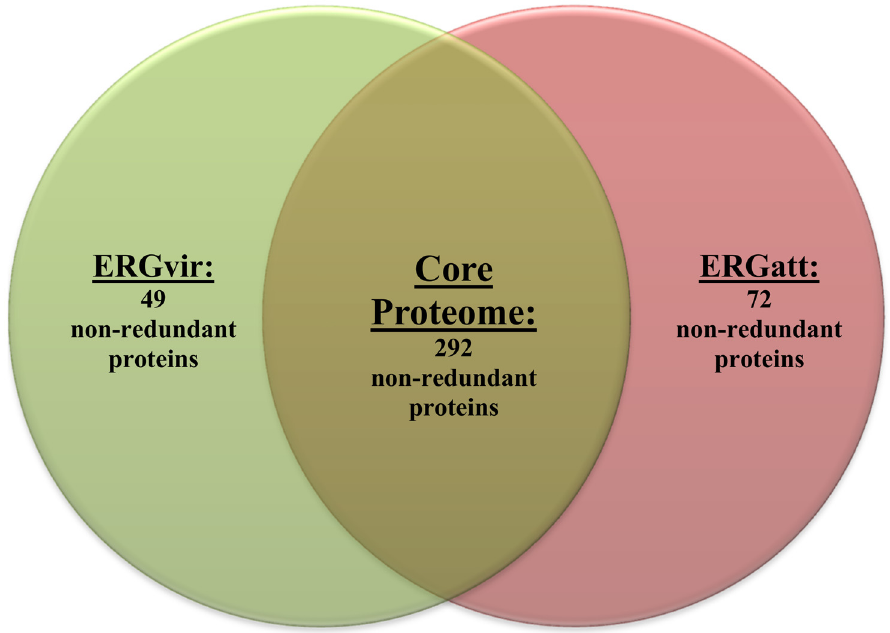
Fig 1. Venn diagram representing the number of non-redundant proteins identified in ERGvir and ERGatt and in both (core proteome) by 1DE-nanoLC-MALDI-TOF/TOF analysis. Three biological replicates per strain were independently used and the results analyzed with Peaks software (using using simultaneously Peaks DB, MASCOT and X!Tandem algorithms).